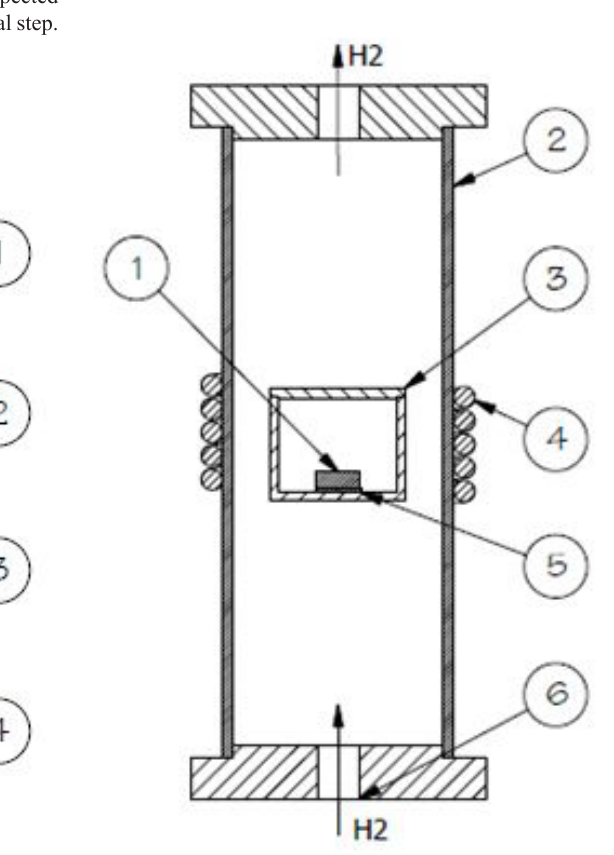
Figure 2. Induction heating jig for pre-sintering and decopperization steps: (1) cathode button; (2) quartz tube; (3) molybdenum crucible; (4) 3-inch coil with four turns; (5) alumina disk; and (6) dry hydrogen